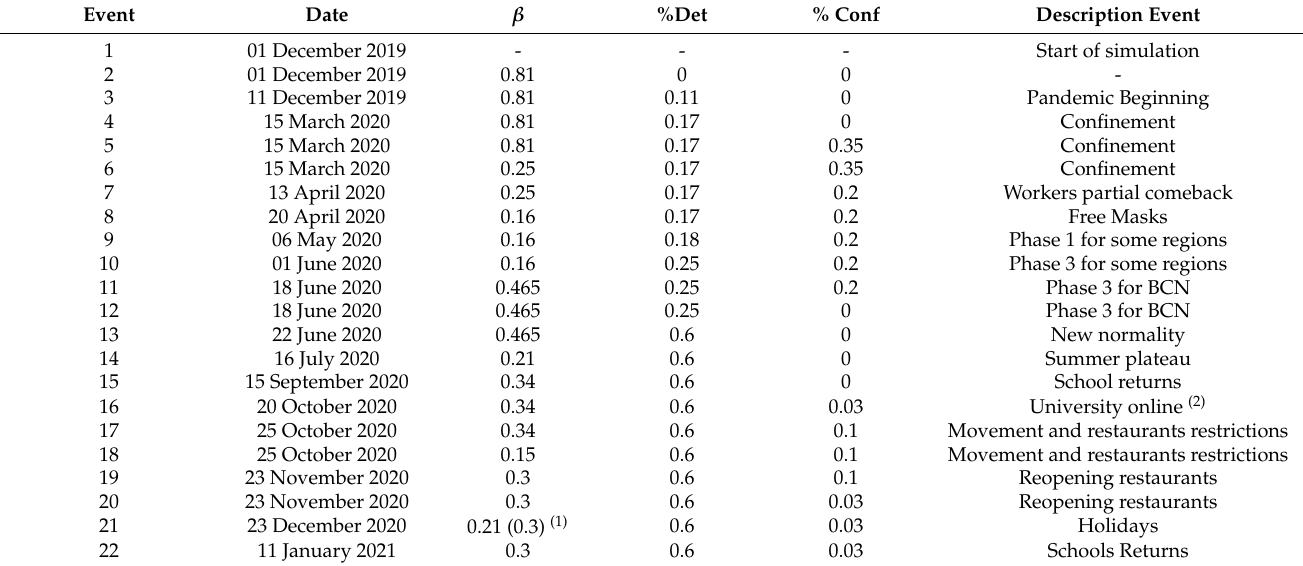
Table 5. Parameters used on the 2.8 simulation scenarios: (1) as a result of the validation process, the correct parameter for this β is 0.3, being added on the 2.9 model. (2) the organization of the online courses needs a week to be fully implemented.